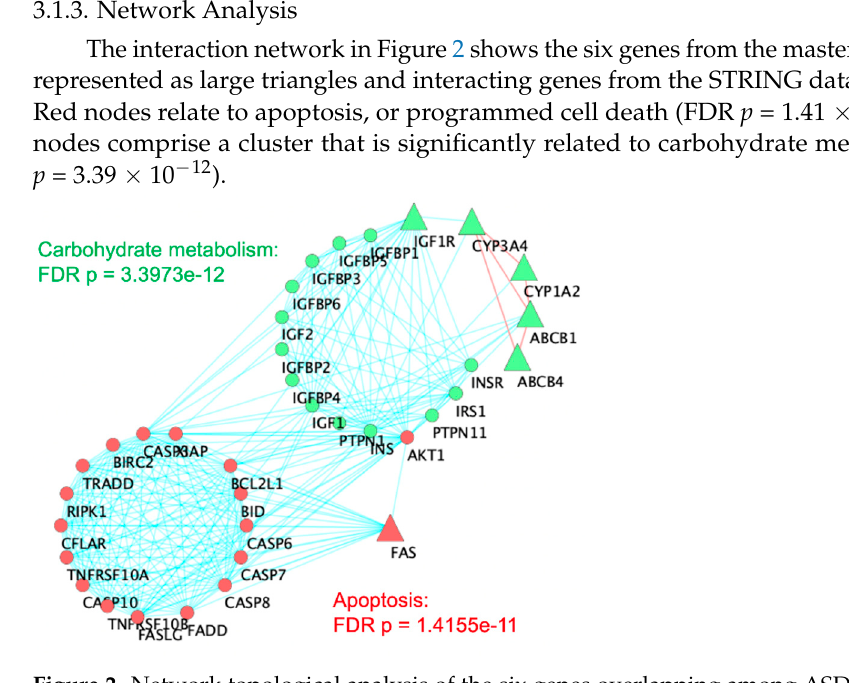
Figure 2. Network topological analysis of the six genes overlapping among ASD, pesticides, and acetaminophen. A cluster analysis of the STRING Protein–Protein Interaction network was carried out in Cytoscape. Triangles indicate the six original genes while circular nodes are first neighbors from STRING database interactions. Red lines connecting triangular nodes indicate connections between six original genes. Red nodes are overrepresented for apoptosis (FDR p = 1.41 × 10 ⁻ 11 ). Green nodes are overrepresented for carbohydrate metabolism (FDR p = 3.39 × 10 ⁻ 12 ).